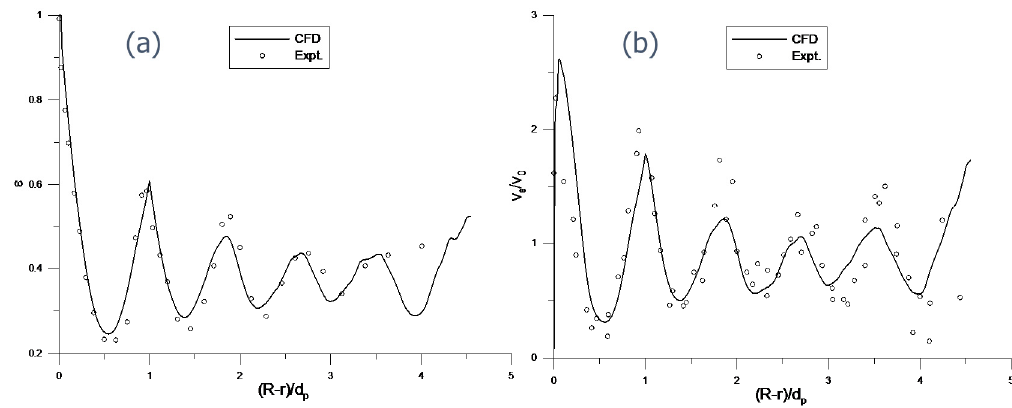
Figure 4. Validation of Computational Fluid Dynamics (CFD) simulations against data from [38] for ( a ) bed void fraction for N = 9.30; and ( b ) normalized axial superficial velocity profile for Re = 532 and N = 9.30.